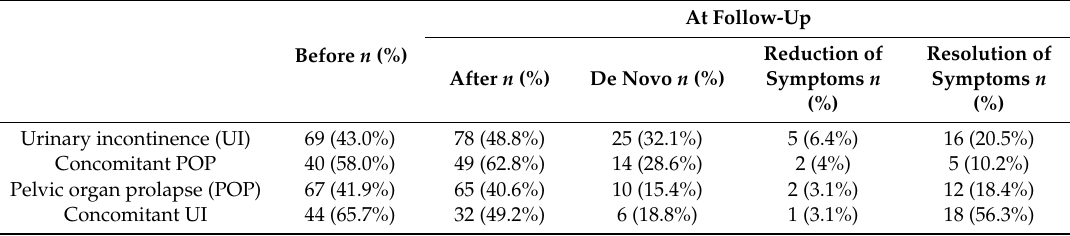
Table 4. Urinary incontinence and POP symptoms prevalence in the study group prior and after oncological